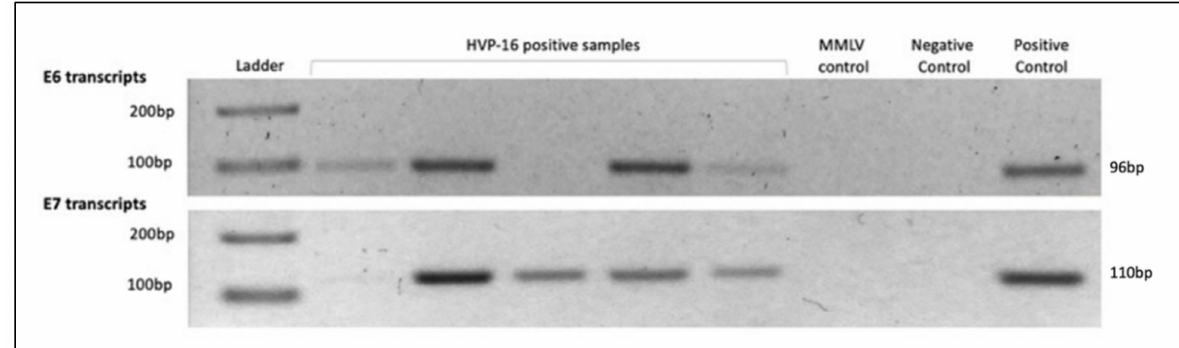
Figure 2. E6 and E7 transcripts in OPSCCs. Agarose gel electrophoresis (2.5%) of products obtained after RT-PCR for HPV16 E6 and E7 gene expression. Left to right: 100 bp DNA ladder, palatine tonsil samples positive for HPV16, MMLV control (HPV16 E6-positive sample without MMLV treatment), negative control (nuclease-free water), and positive control (CasKi cells). Expected molecular weights are 96 bp and 110 bp for E6 and E7 transcripts,